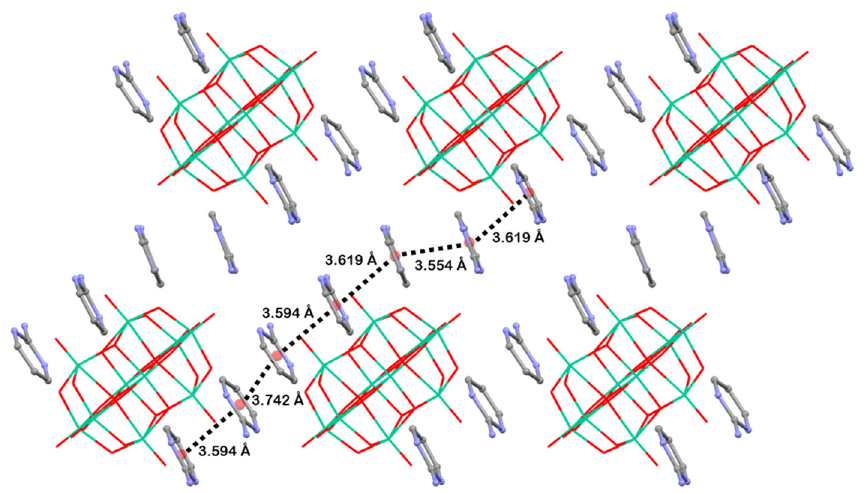
Figure 3. Partial supramolecular structure of Compound 1 where π – π stacking interactions between the aromatic rings of pyrimidine and the distance between centroids are shown (black dashed line). Vanadium atoms are represented in green.